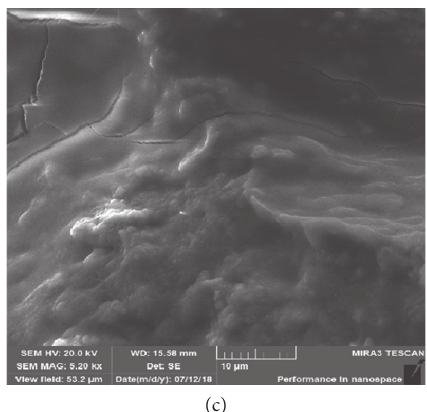
Figure 12: SEM images of silt sand treated with lignin before and after freeze-thaw.